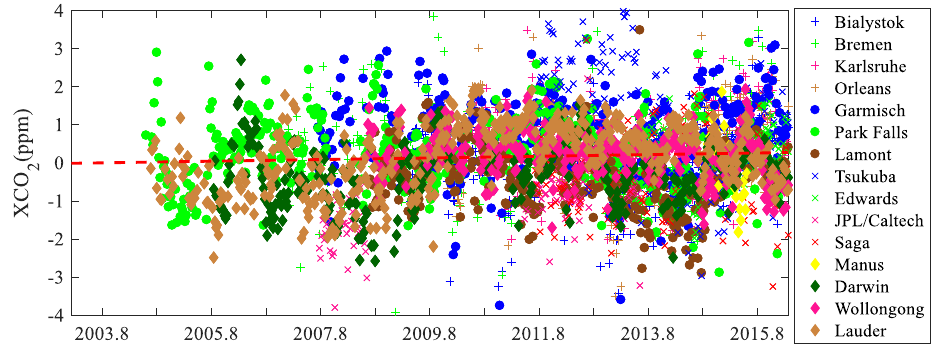
Figure 10. XCO 2 difference between GM-XCO 2 and TCCON measurements from 2003 to 2016 using available datasets (GM-XCO 2 minus TCCON XCO 2 ). All GM-XCO 2 values within 0.5 degrees around the TCCON sites (different markers) were averaged for the difference calculation.